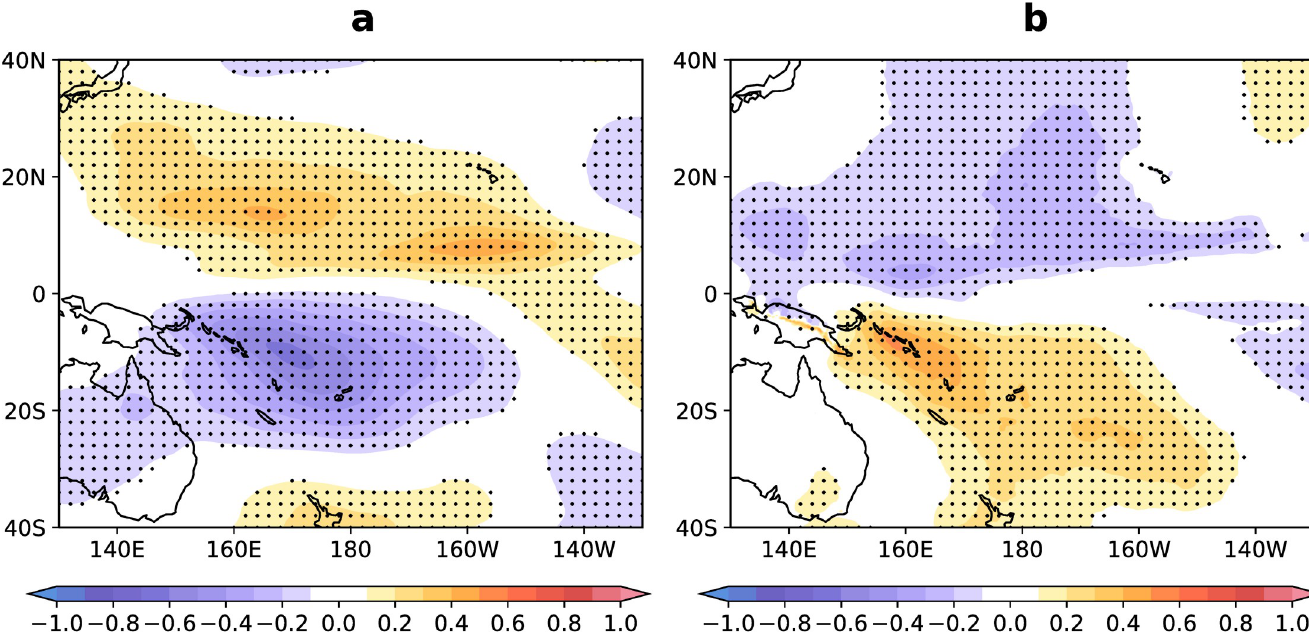
Fig 1. MCA response to El Ni ñ o. The shaded area indicates the correlation coefficient between the ONI (˚C) and the meridional wind speed anomaly (m s -1 ) at 200-hPa (a) and 850-hPa (b). The stippled regions indicate a significance of > 95% confidence level using the Student’s t-test.